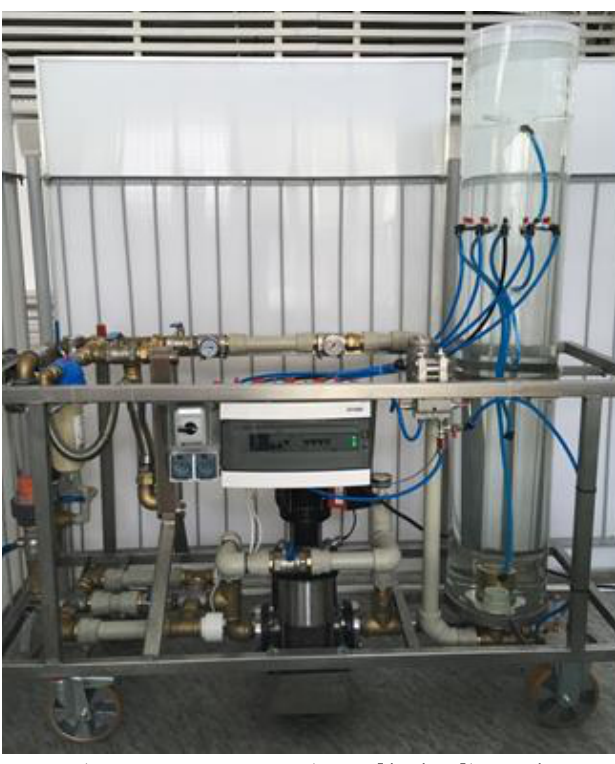
Fig. 3: FLOW-30 Experimental hydraulic stand The experimental stand FLOW-30 allows performing thermal and hydraulic measurements in 1:1 scale, both in heat transfer and geometrical terms. The stand is equipped with water temperature and flow rate measurement and control systems. A number of pressure sensors allow to determine pressure drop. It is possible to correlate the flow rate with pressure drop and water gap thickness. The heat transfer coefficient [W∙m -2 ∙K -1 ] can be therefore determined.